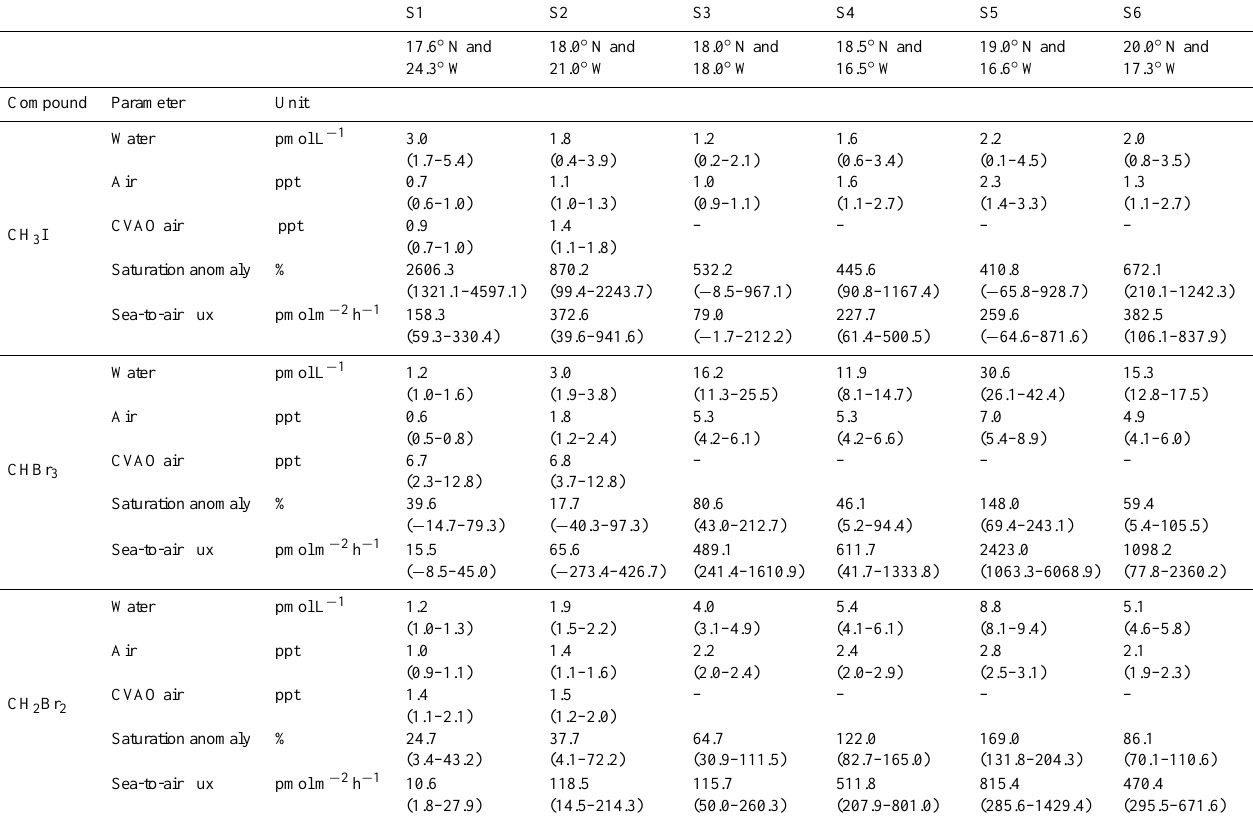
Table 2. Results of halocarbon measurements (water and air) and calculations (saturation anomalies and sea-to-air fluxes) for all six diel stations and parallel air sampling at